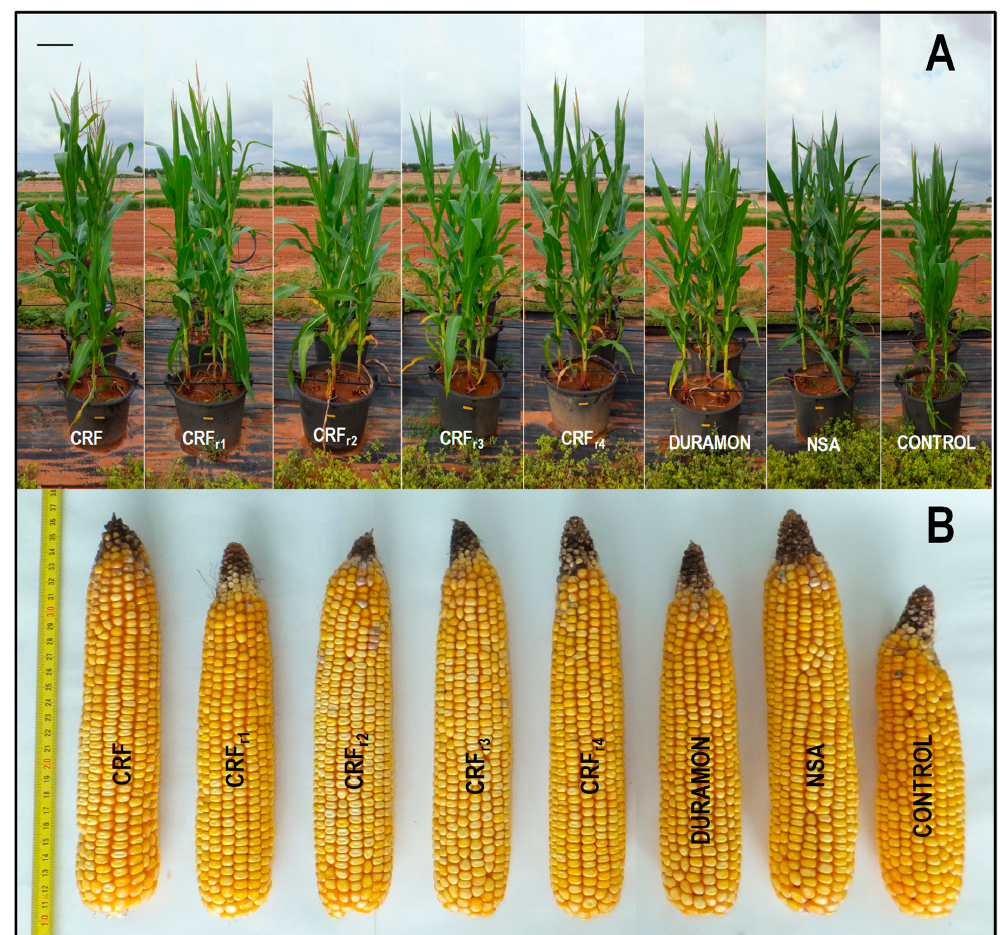
Figure 2. Maize responses in the growth ( A ) and ear size ( B ) to the applied fertilizers (CRF, CRF r1 ‐ CRF r4 , DURAMON ® and NSA) compared to CONTROL at the microscale (CRF, DURAMON ® and NSA: 350 kg ha − 1 ; CRF r1 : 315 kg ha − 1 ; CRF r2 : 280 kg ha − 1 ; CRF r3 : 245 kg ha − 1 ; CRF r4 : 210 kg ha − 1 ). Metrics in figure ( B ) correspond to cm.